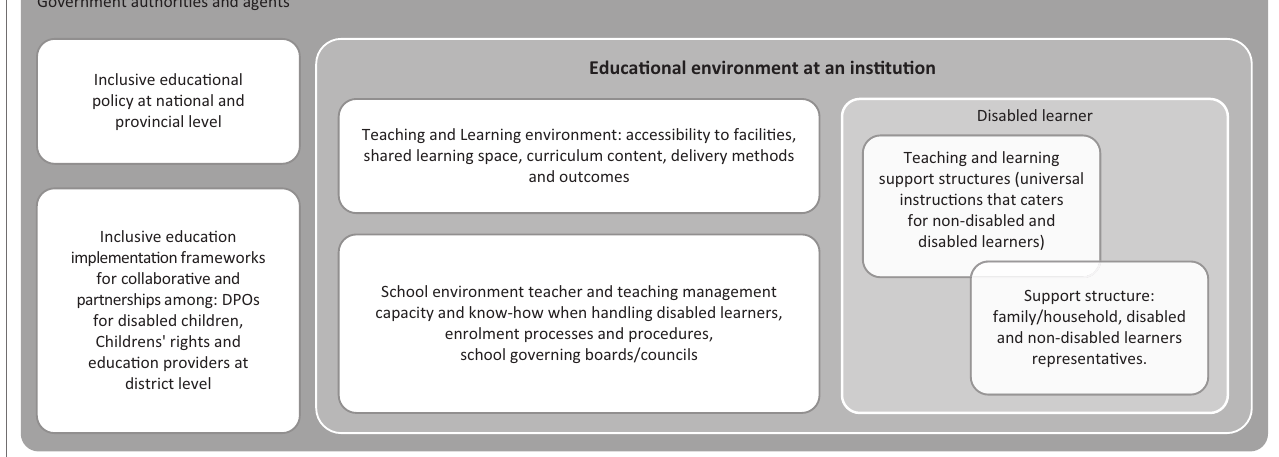
FIGURE 1: Role-players for the educational success of disabled